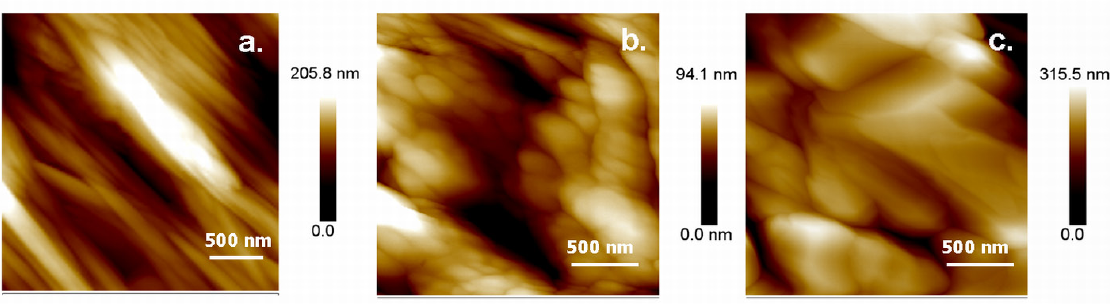
Figure 7. AFM topographic images of free air dried BC (a), lyophilized BC (b), and BC/CS composite